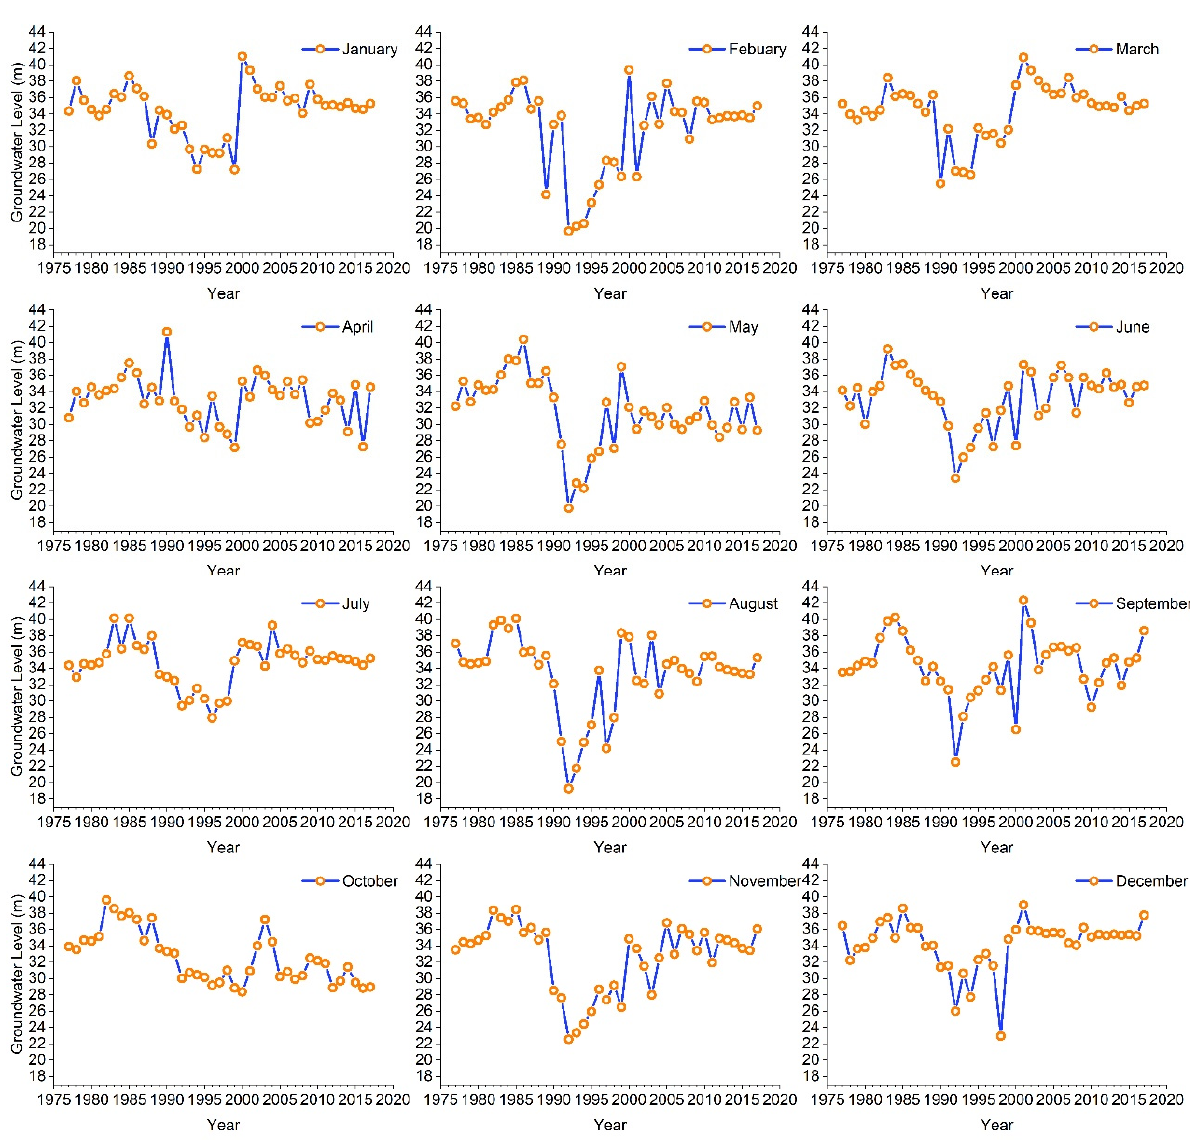
Figure 4. Variation trend in the monthly groundwater level in the Gnangara region.